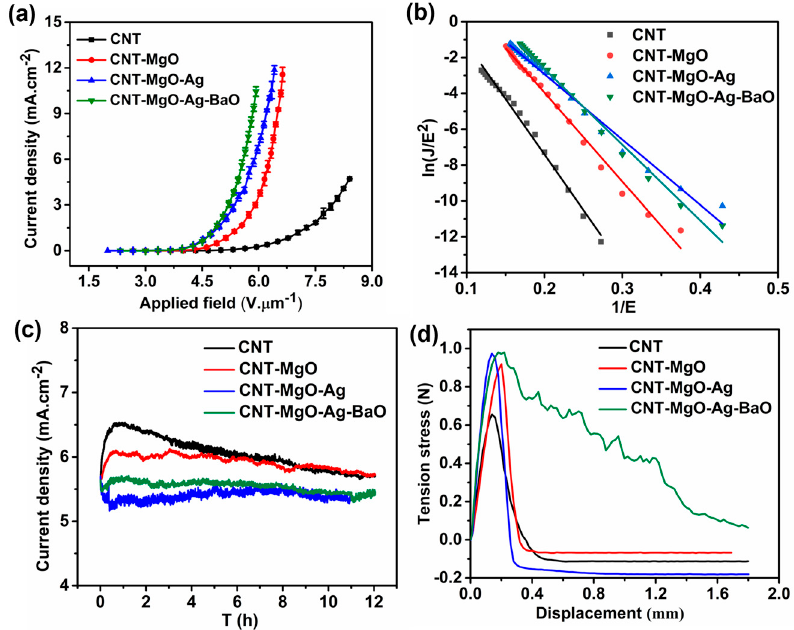
Figure 5. Field emission performances and tensile tests of the CNT and CNT-MgO, CNT-MgO-Ag, and CNT-MgO-Ag-BaO composite samples. ( a ) J-E curves; ( b ) F-N curves; ( c ) FE stability tests; ( d ) Tensile tests. Table 1. Comparison of FE parameters of CNT − based samples.